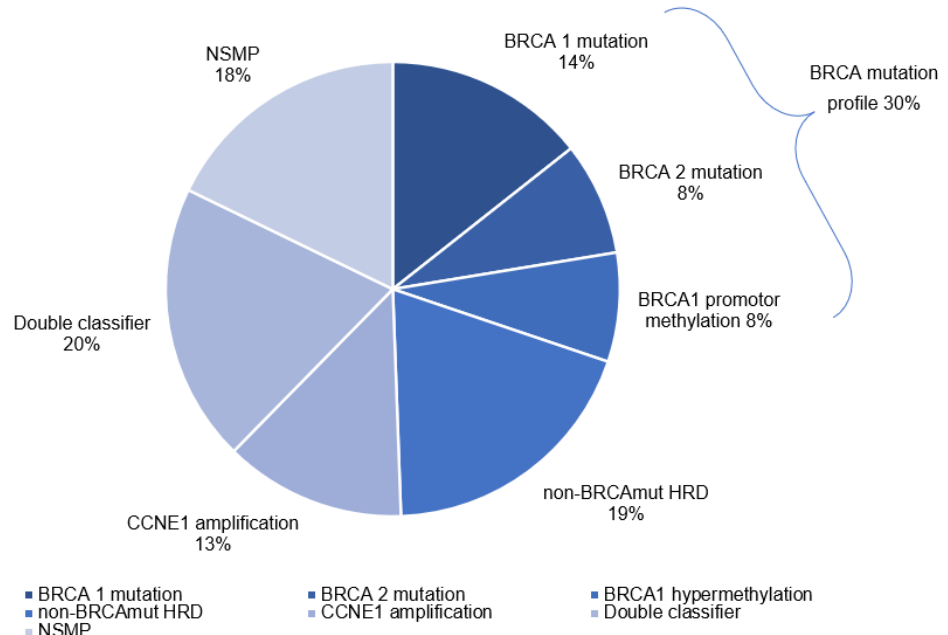
Figure 2. Pie chart depicting the five molecular profiles. The pie chart consists of (1) BRCA mutation or BRCA1 promotor methylation, (2) non-BRCAmut HRD, (3) CCNE1 gain/amplification, (4) double positive (non-BRCAmut HRD and CCNE1 gain/amplification), and (5) no specific molecular profile (NSMP).